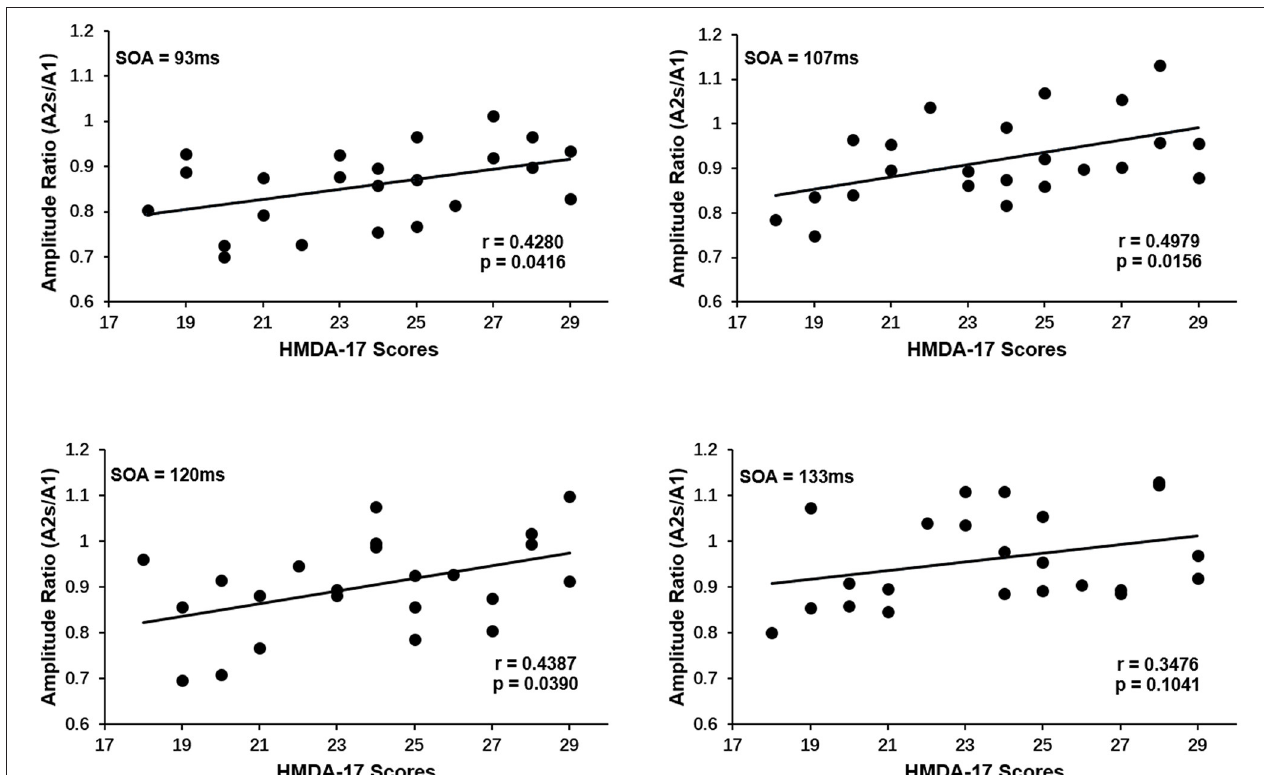
FIGURE 3 | Correlation of paired-pulse suppression with symptom severity of depression for each SOA in MDD group. An increase in the amplitude ratios (A2s/A1) is associated with an increase in HAMD-17 scores. The Spearman’s correlation coefficient and p-values for each SOA were present in the lower right corner. Only at SOA of 133ms was the correlation not